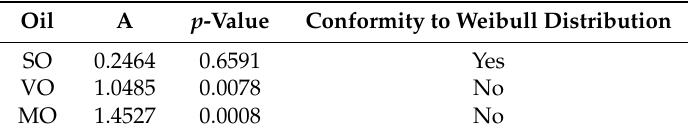
Table 4. Hypothesis test of conformity to Weibull distribution of oils alone in AC.